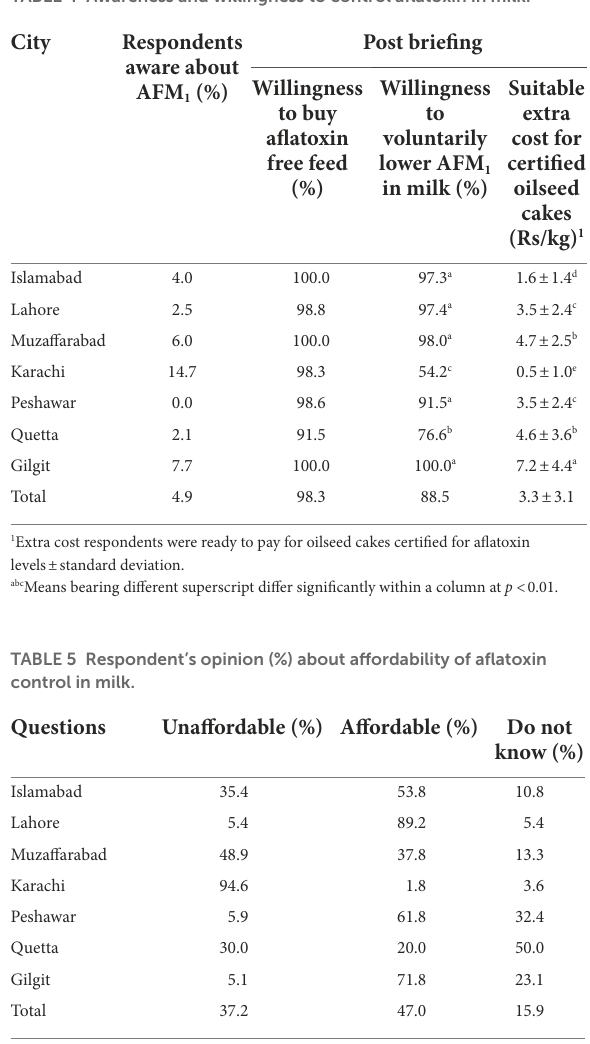
TABLE 4 Awareness and willingness to control aflatoxin in milk.